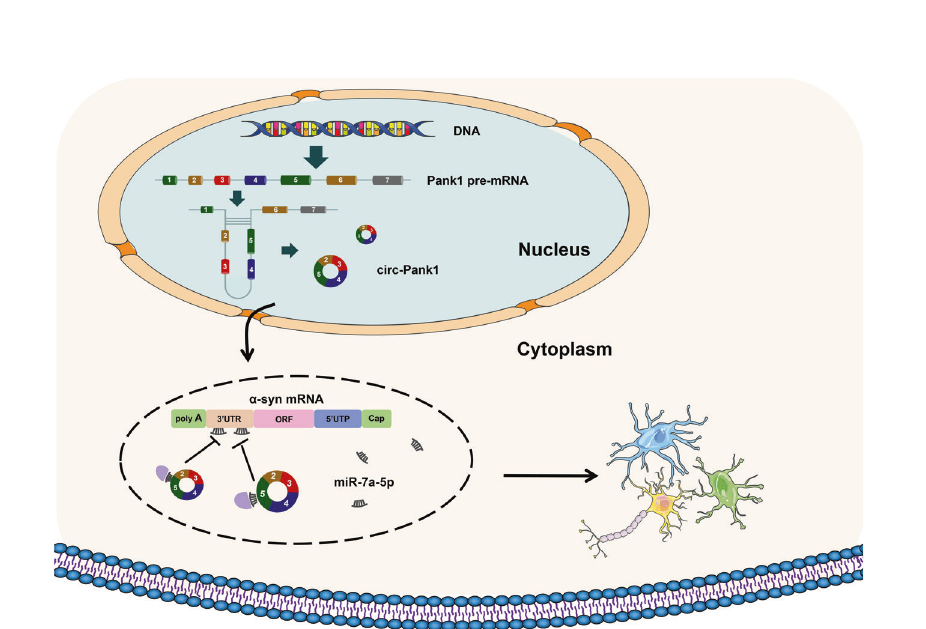
Fig. 6 Silencing circ-Pank1 can improve the PD-like motor dysfunction in mice treated with rotenone. A Experimental schematic diagram. After 4 weeks of continuous administration of rotenone, the adeno-associated virus vector (AAV-sh-circ-Pank1) with fl uorescence-speci fi c knockdown of circ-Pank1 (AAV-sh-circ-Pank1) and the control GFP were injected by stereotactic brain injection. Adeno-associated virus vector (AAV-GFP) was injected into the SN of PD model mice treated with rotenone. B Schematic diagram of the brain stereotactic injection site of virus. C Representative fl uorescence image of the virus-transfected section; scale bars, 100 μ m and 50 μ m. D qRT – PCR was used to detect the expression of circ-Pank1 after injection of AAV-sh-circ-Pank1 into the SN of PD model mice treated with rotenone ( n = 4). E , F Immunohistochemical detection of the number of TH-positive cells after the injection of AAV-sh-circ-Pank1 into PD model mice treated with rotenone; scale bars, 500 μ m ( n = 4). G , H Western blot analysis of α -syn protein levels in the SN of PD model mice treated with rotenone after injection of AAV-sh-circ-Pank1. I , J Western blot analysis of TH protein levels in the SN of PD model mice treated with rotenone after the injection of AAV-sh-circ-Pank1 ( n = 4). K – R PD model mice treated with rotenone after the injection of AAV-sh-circ-Pank1 were subjected to a pole climbing test K , fi eld test ( L – N ) and step measurement ( O – R ) to evaluate the exercise ability ( n = 8). Data are presented as mean ± SD. * P < 0.05, ** P <